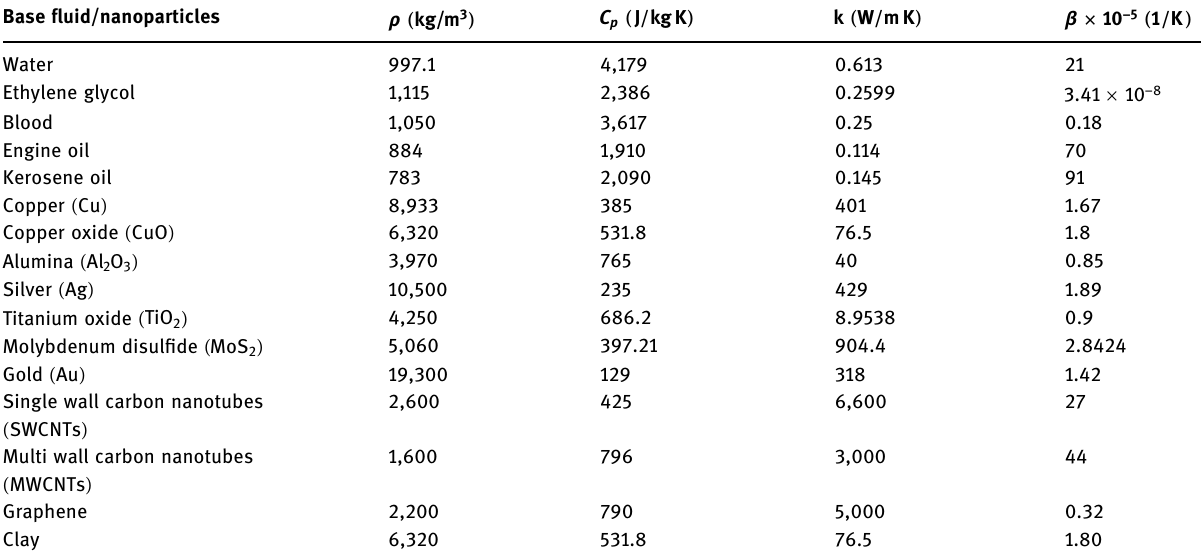
Base fl uid/nanoparticles